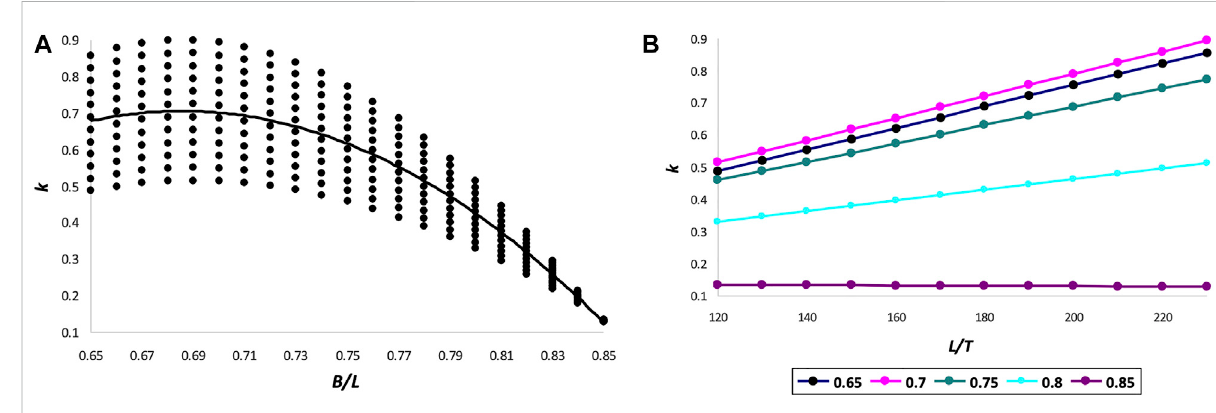
FIGURE 6 Functional dependences for changes in the value of k by B / L (A) and by L / T (B)